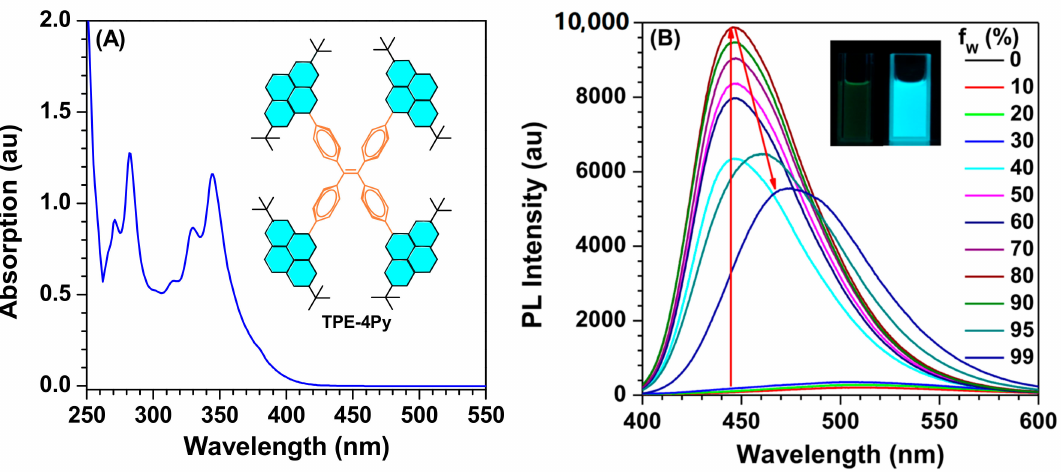
Figure 1. ( A ) UV-vis absorption spectrum of TPE-4Py in THF solution. Concentration: 10 µ M, inset: molecular structure of TPE-4Py; ( B ) The PL spectra of TPE-4Py in THF/H 2 O mixtures with different water fractions. Concentration: 10 µ M; excitation wavelength: 330 nm; inset: photographs of theTPE-4Py in the THF/H 2 O mixtures ( f W = 0% and 90%) taken under the illumination of a 365 nm UV lamp.